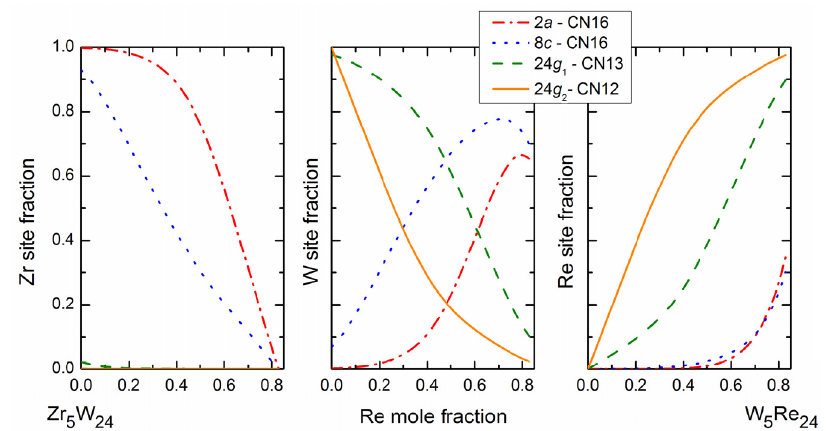
Figure 8. Calculated site occupancies at 1500 °C for the χ phase in the Zr–W–Re system along the composition line joining Zr 5 W 24 and W 5 Re 24 (dashed line in Figure